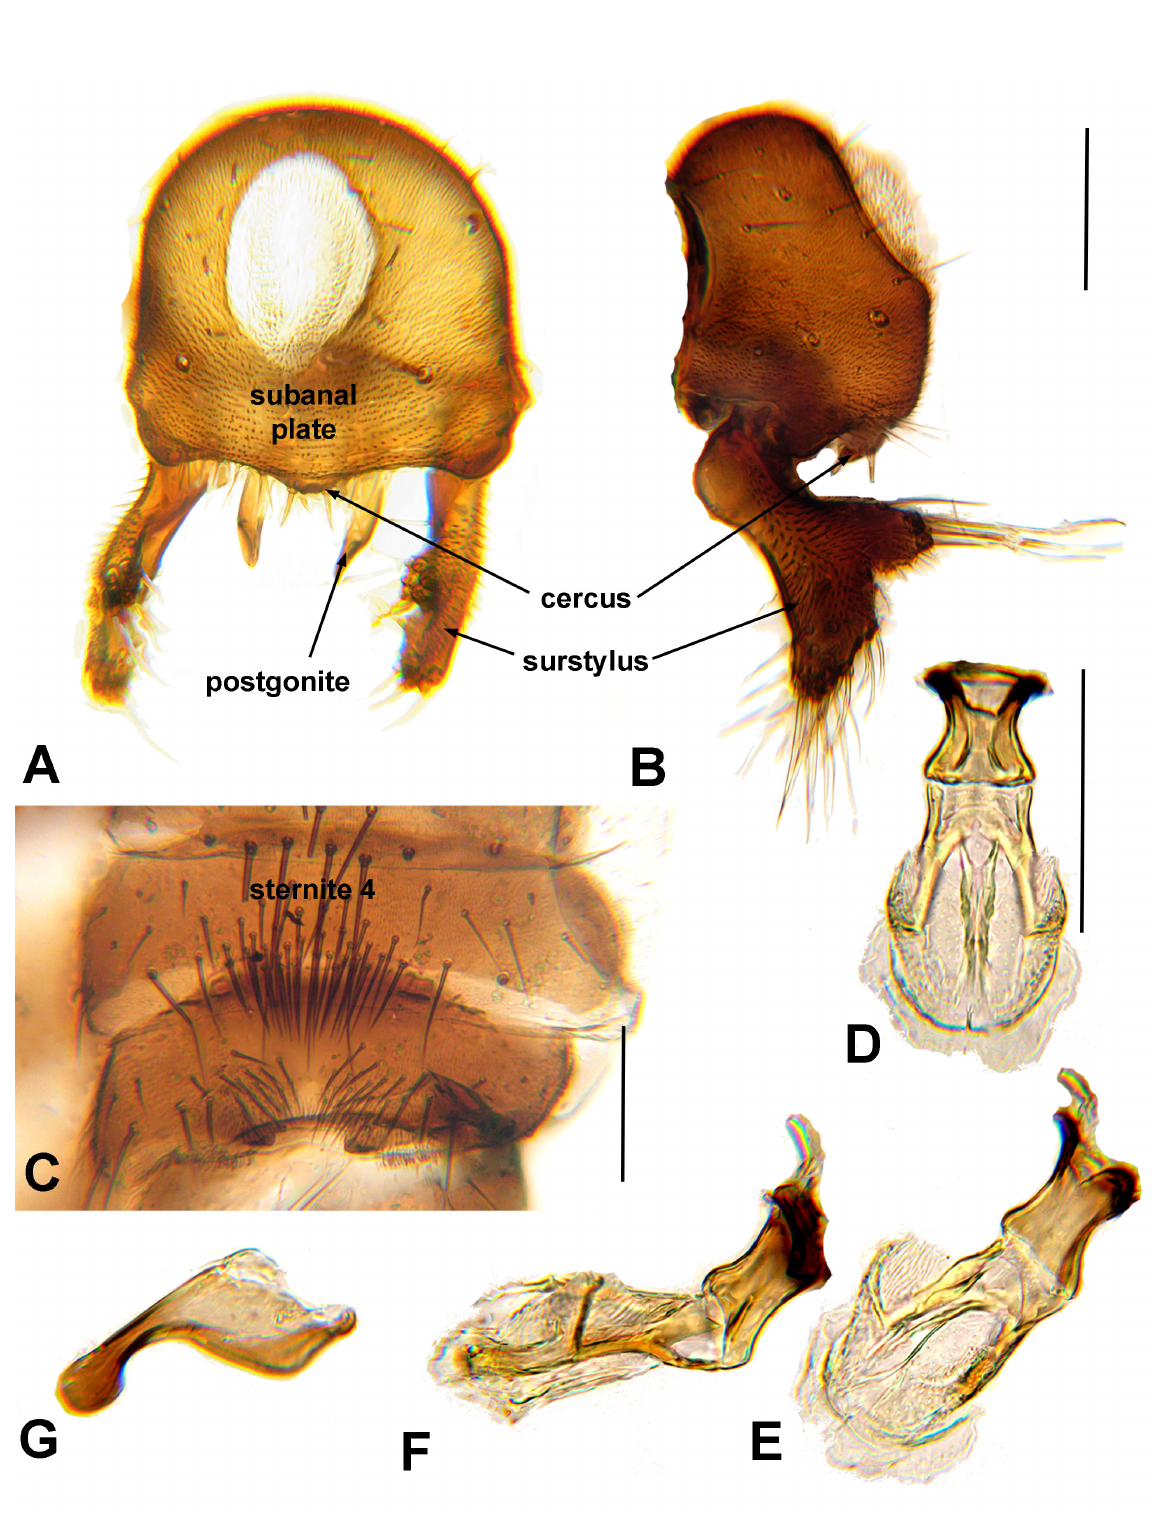
Fig. 18. Rudolfina pilosa sp. nov., male terminalia (debu01086241). A . Epandrium, surstylus and cercus, caudal view. B . Same as preceding, lateral view. C . Sternite 5, ventral view. D . Phallus and ejaculatory apodeme, dorsal view. E . Same as preceding, dorsolateral view. F . Same as preceding, lateral view. G . Postgonite, lateral view. Scale bars: A–B = 0.10 mm; C = 0.10 mm; D–G = 0.10